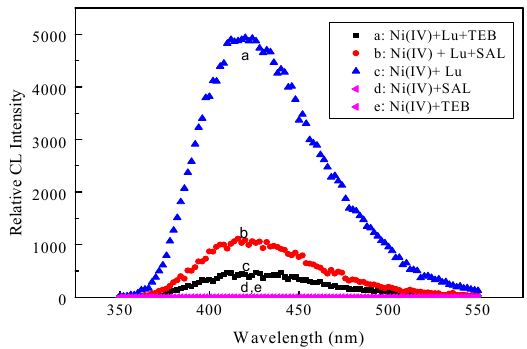
Figure 5. CL spectra of the Lu-Ni(IV)-SAL/TEB system. Reaction conditions: [Ni] = 3.0 × 10 −7 M; [Lu] = 1.0 × 10 −4 M; [OH − ] = 0.006 M; [TEB] = 1.0 × 10 −5 M; [SAL] = 1.0 × 10 −5 M.